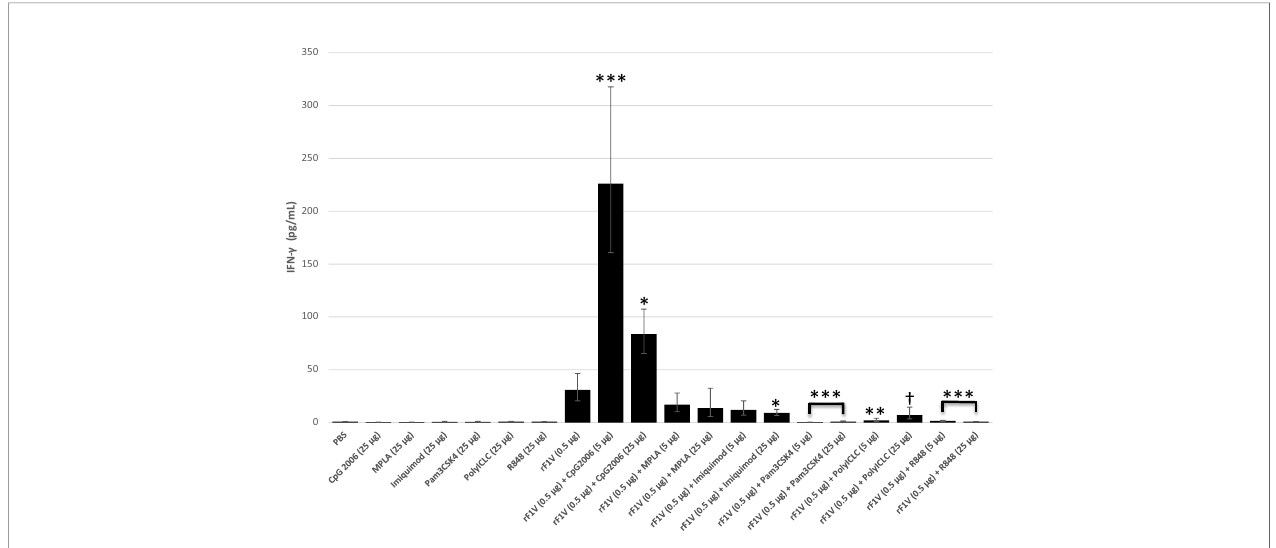
FIGURE 4 | Production of IFN- g by whole splenic lymphocytes from mice vaccinated with rF1V and TLR agonists. BALB/c mice were vaccinated twice, subcutaneously, 3 weeks apart with mock/PBS (n=15), rF1V (n=14), with and without 5 or 25 µg of TLR agonists (n=5). At 28 days post vaccination, mice were euthanized and spleens were harvested. Splenocytes (10 6 cells) were re-stimulated in the presence of rF1V (25 µg/ml) for 48 hours. The levels of IFN- g were measured by the Luminex bead-based suspension assay. Log transformed values were analyzed by two-way ANOVA (treatment x assay date) and results are reported as the geometric mean and geometric standard error. p -values are obtained from the main effect contrasts of the ANOVA model. No adjustment has been applied for multiple comparisons. † p<0.05, *p<0.01, **p<0.001, ***p<0.0001 (Comparisons show signi fi cant differences versus the rF1V (0.5 µg)